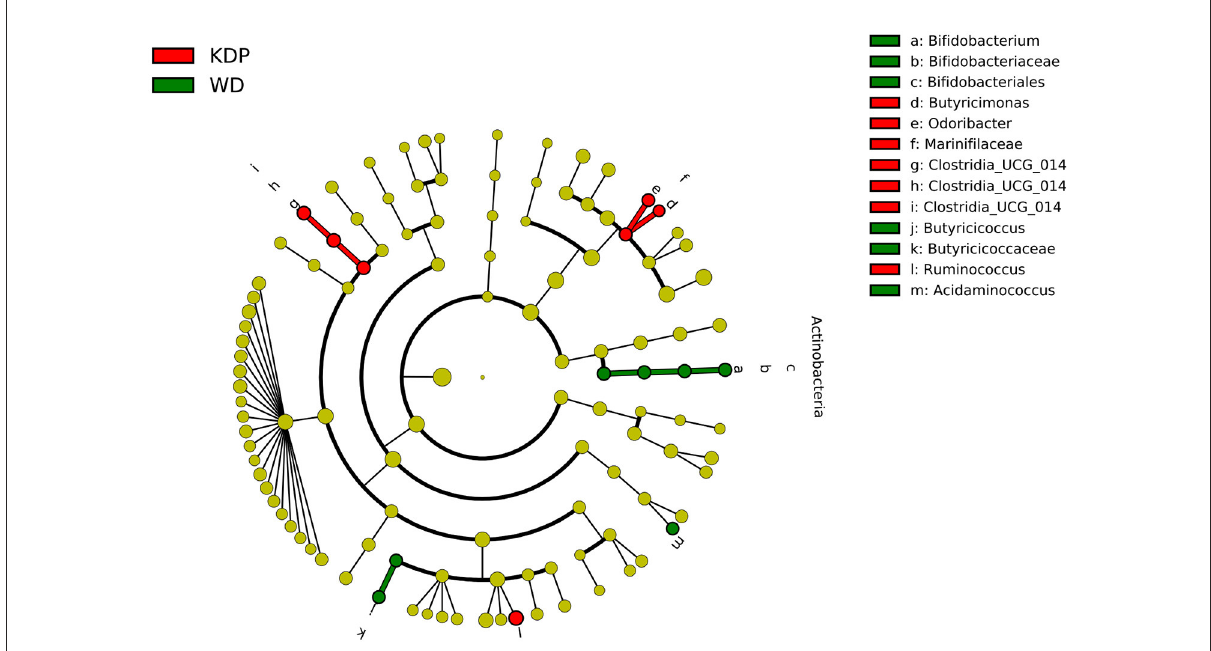
FIGURE4 Differential taxa between the KDP and WD groups in the post-intervention (LEfSe analysis, adjusted p < 0.05, log 2 fold change > 2).